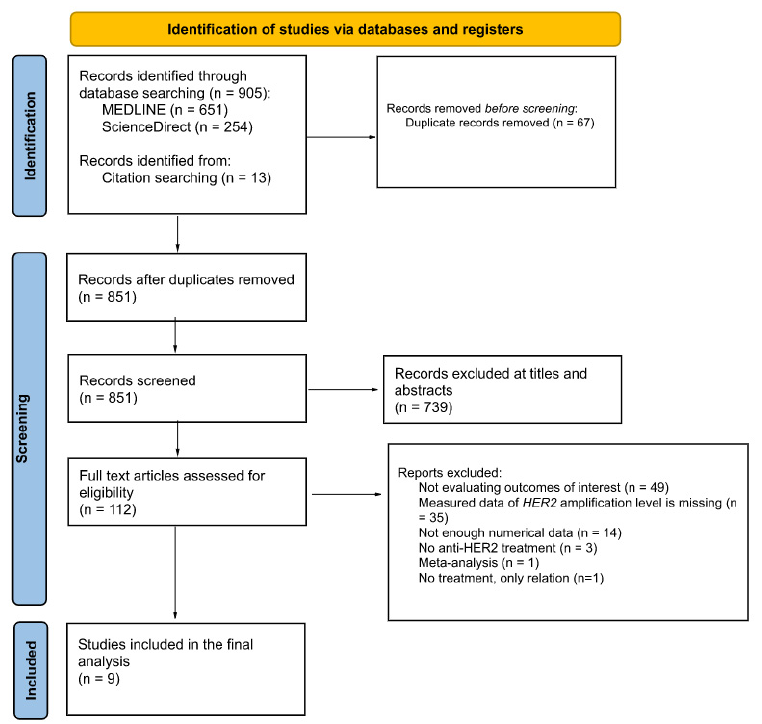
Figure 1. PRISMA Flow Diagram.